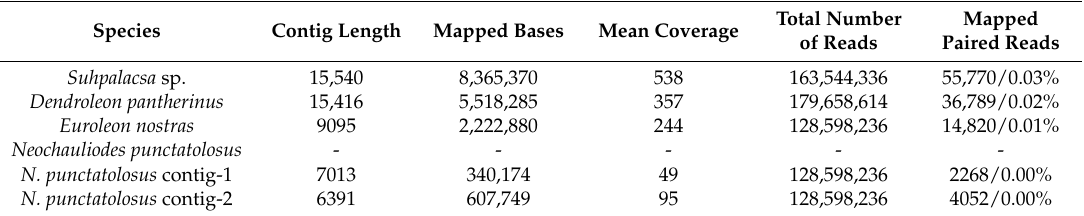
Table 2. Statistics associated to the sequencing of mitochondrial genomes using NGS-Illumina technology in four neuropteridan